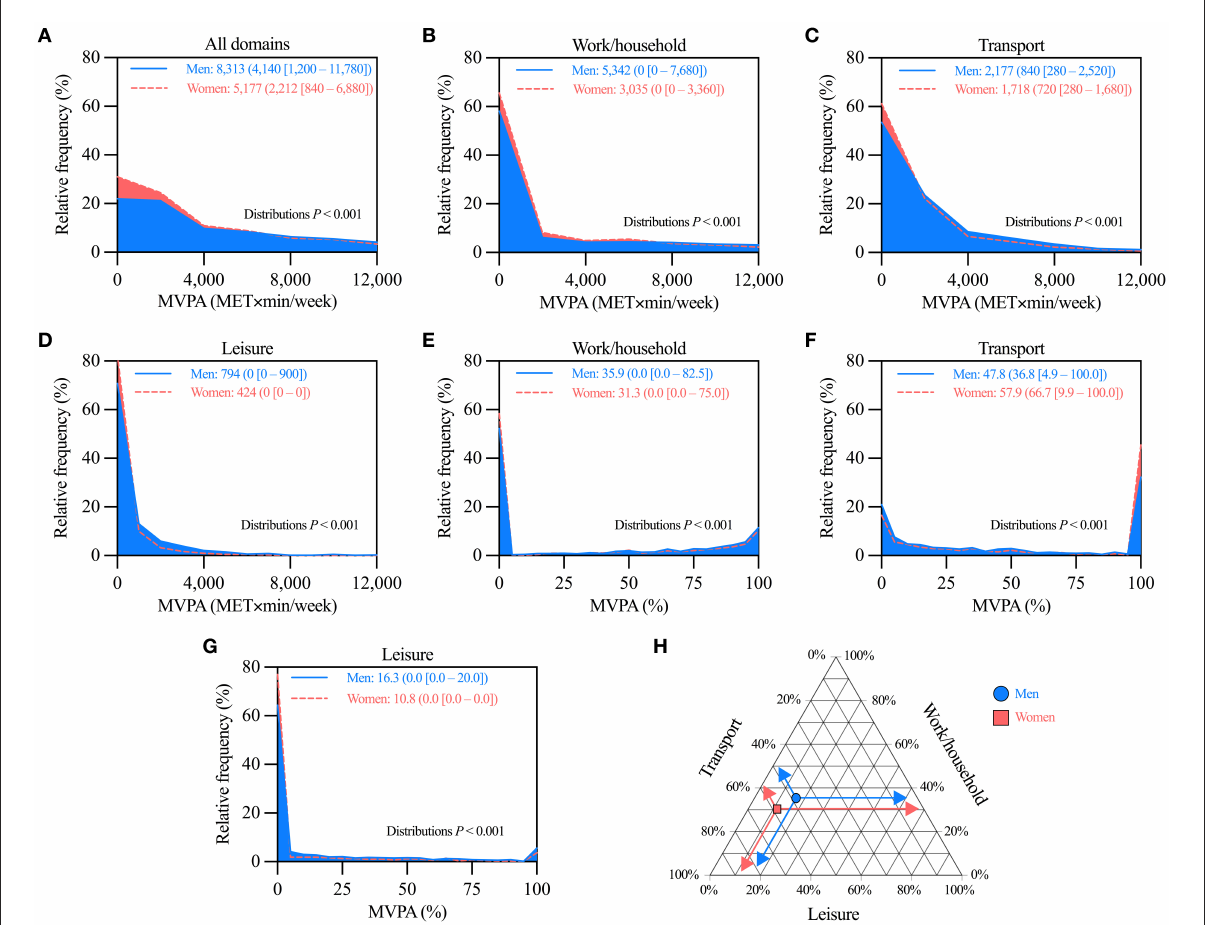
FIGURE2 Comparison of moderate-vigorous physical activity (MVPA) levels between men and women that reported some MVPA . (A–D) Histograms comparing the distributions of MVPA considering (A) all, (B) work/household, (C) transport, and (D) leisure domains. (E–G) Histograms comparing the distributions of the relative contribution to MVPA of (E) work/household, (F) transport, and (G) leisure domains. (H) Ternary plot summarizing the mean relative contribution to MVPA by domain in men and women. In panels A–G , values are mean (median [25–75th percentile]) of MVPA; distributions more skewed to low MVPA values denote lower MVPA. n = 1,494 for men, and 2,317 for